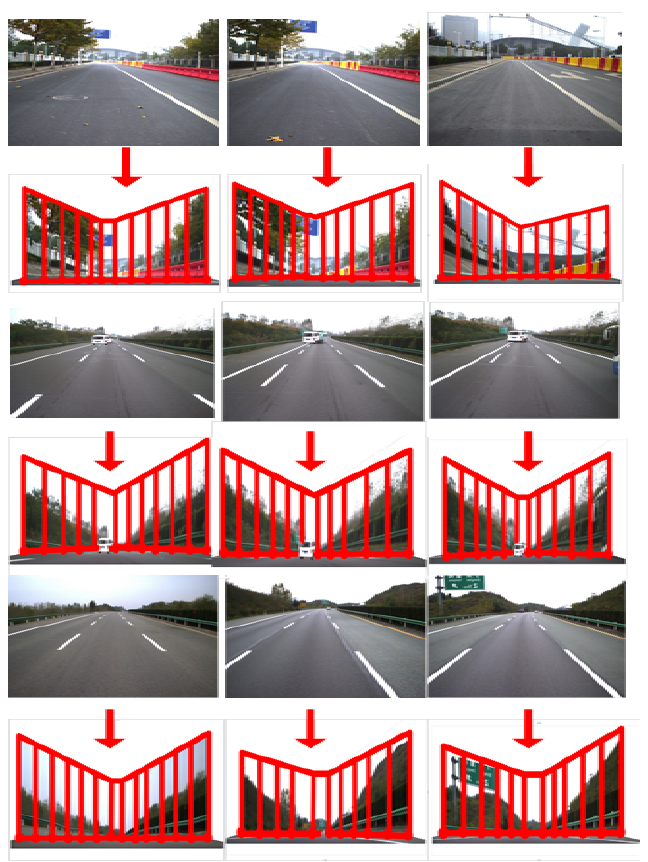
Figure 12. Traffic scenes construction from road